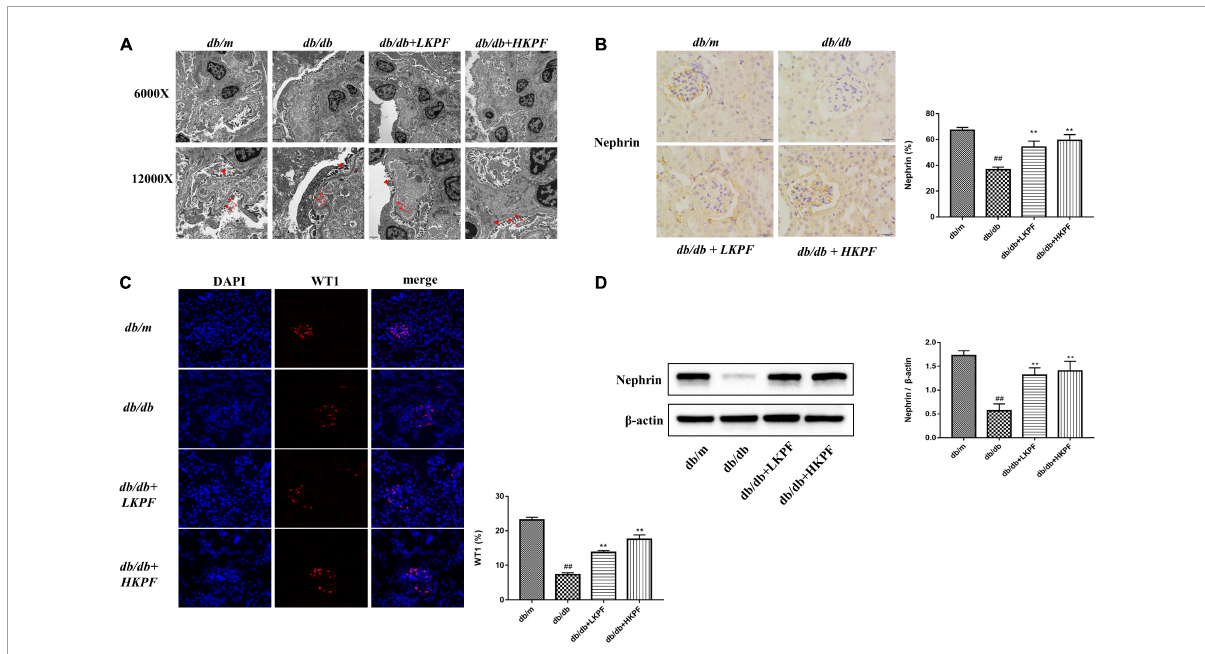
FIGURE3 Kaempferol attenuated podocytes injury in db/db mice. (A) TEM (6000 × , bar = 2 µ m and 12000 × , bar = 1 µ m) micrograph, showing the GBM thickness (arrows) and FPs width (triangle). (B) Immunohistochemical (IHC) analysis of nephrin positive cells (400 × , bar = 20 µ m) and quantification of IHC staining for nephrin ( n = 5). (C) IF analysis of podocyte nucleoprotein WT1 in kidney tissue. The tissues were stained with an antibody against WT1 (red), DAPI (blue) was used to stain the cellular nucleus (400 × , n = 5). And quantification of IF stained for WT1 ( n = 5). (D) WB assay and quantitative analysis of nephrin expression after KPF treatment, β -actin was used as internal references; data from each group are expressed as the mean ± SD ( n = 3) from three repeated WB experiments. The data were presented as the mean ± SD ( ## p < 0.01 vs. db/m